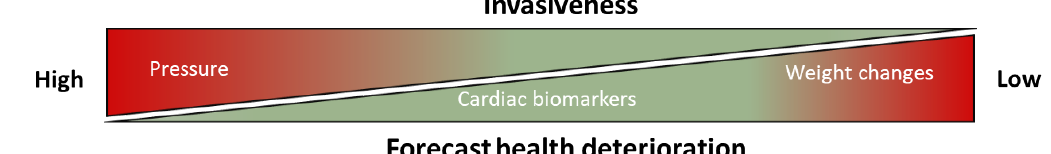
Figure 5. Schematic representation of the invasiveness and the potential for early intervention of different remote monitoring strategies.